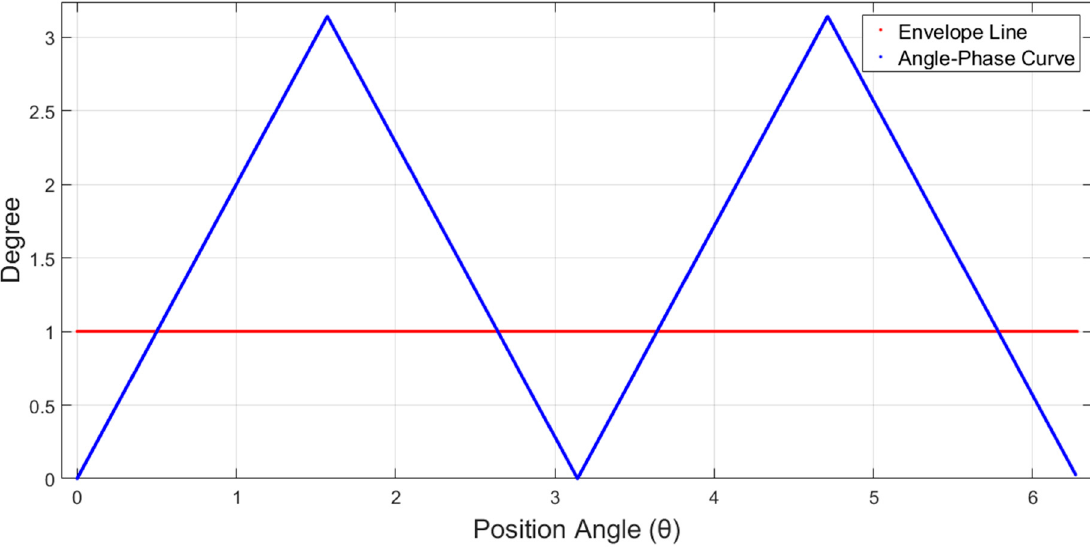
Figure 5. Simulated envelope line and angle relations of 𝑘 (cid:3028)(cid:3040)(cid:3043) = 0 .